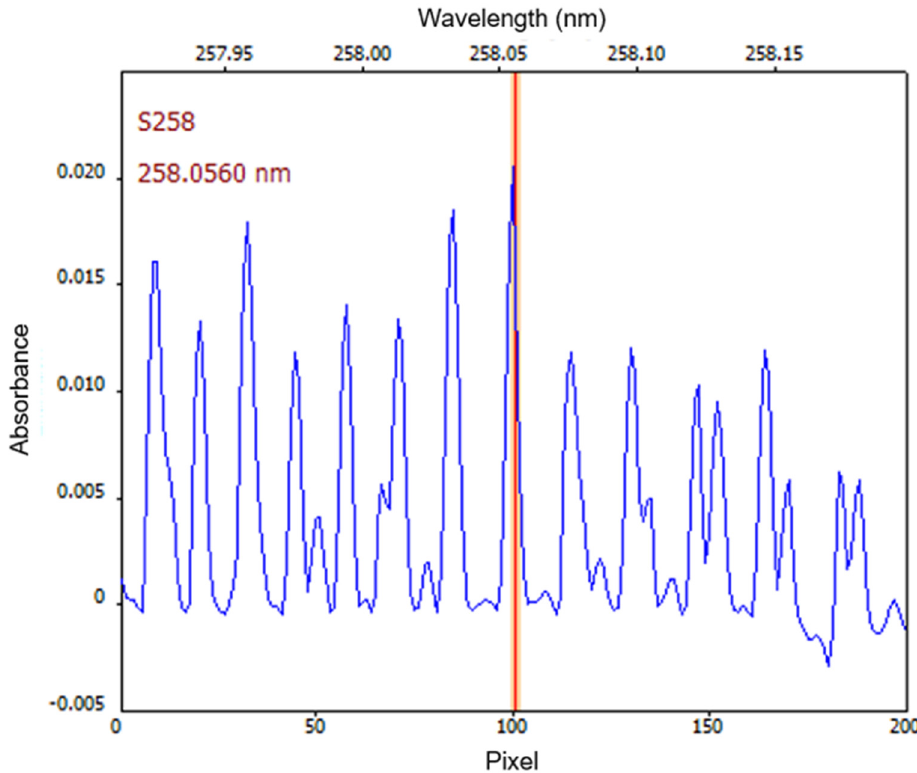
Figure 2. Wavelength-resolved absorbance spectrum of CS ( blue curve ) in the vicinity of the most prominent wavelength at 258.0560 nm ( red line ). The orange bar represents the range adduced for the measurement when considering three pixels.